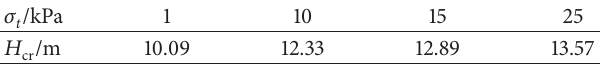
Table 4: Contrast of limit height under different tensile strength.